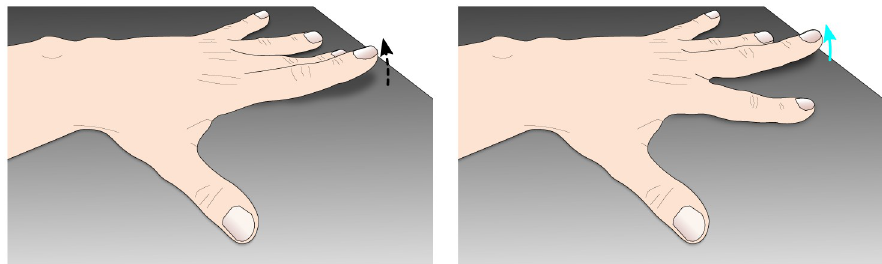
Fig 2. Schematic illustration of a swap in fingers’ motion. The original motion of the index (i.e., the real motion from the user, the dashed arrow) is redirected onto the middle finger the user sees (i.e., the displayed motion, the cyan arrow). (a) Subject’s real movement from the real source finger . (b) What the subject sees, i.e., the displayed destination finger